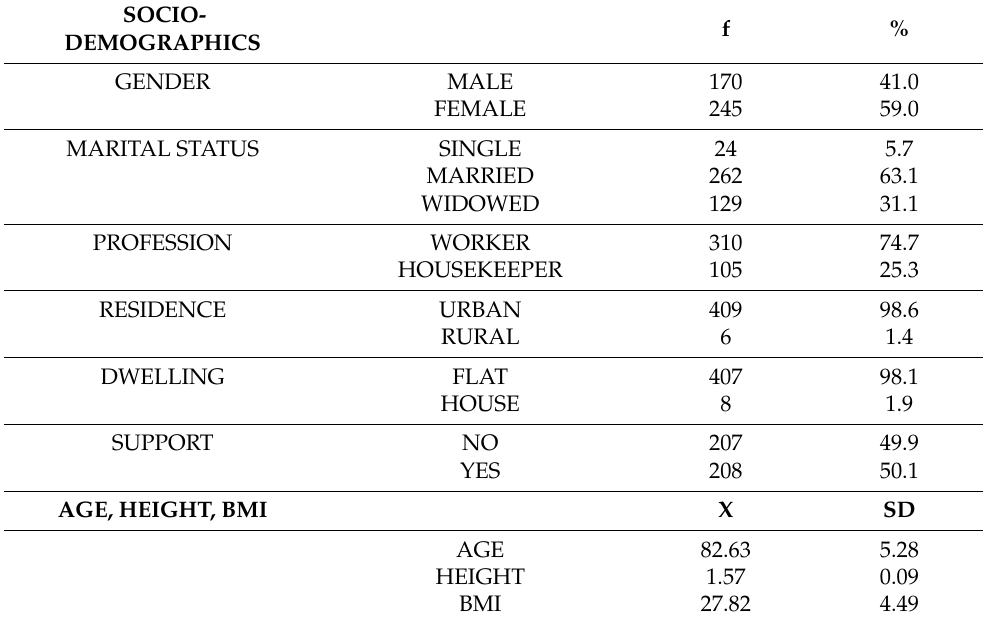
Table 2. Socio-demographic variables, and the age, height, and ibm descriptive values.